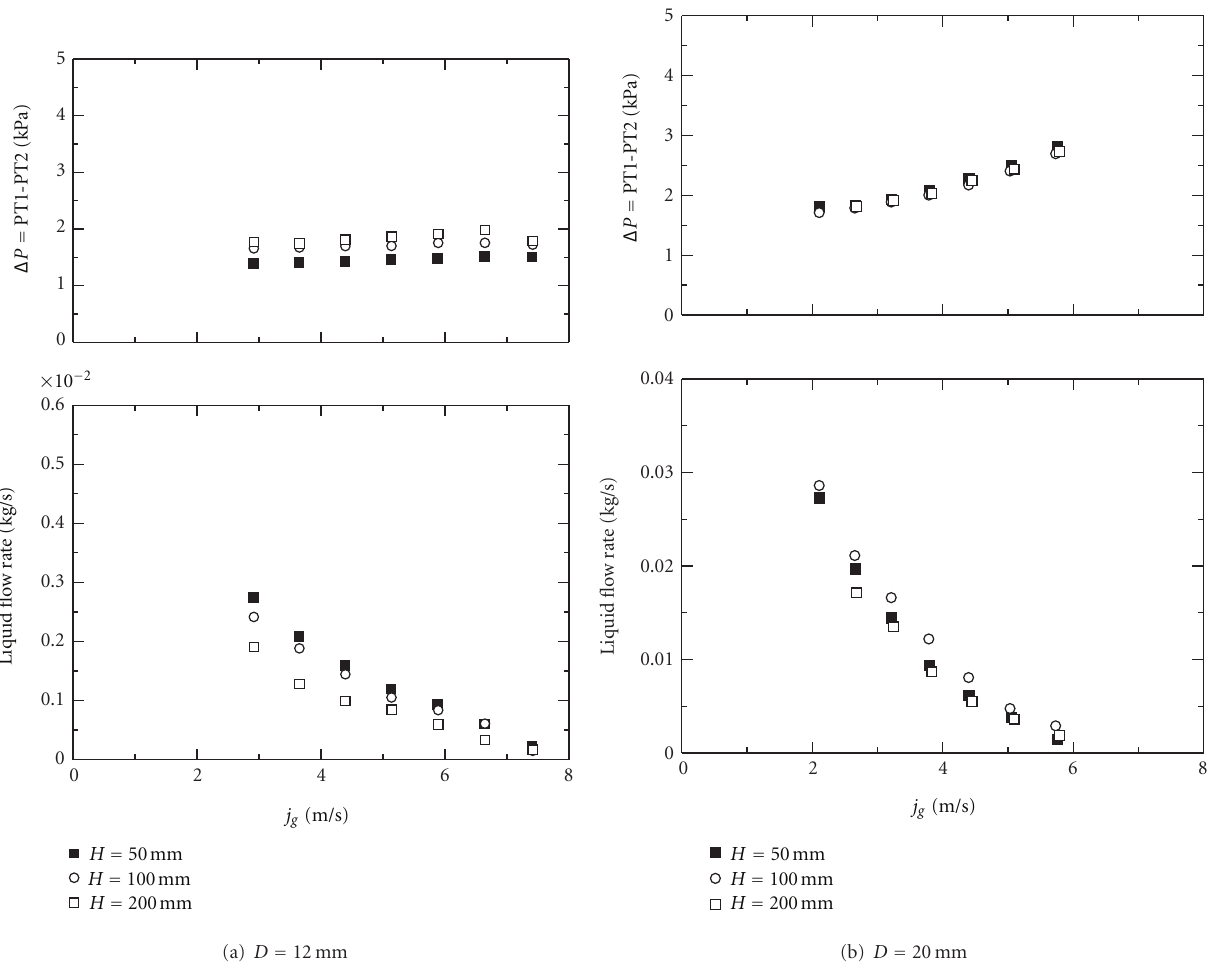
Figure 12: Variation of the pressure di ff erence (PT1-PT2) and the downward liquid flow rate with superficial air flow rate for di ff erence water level and tube